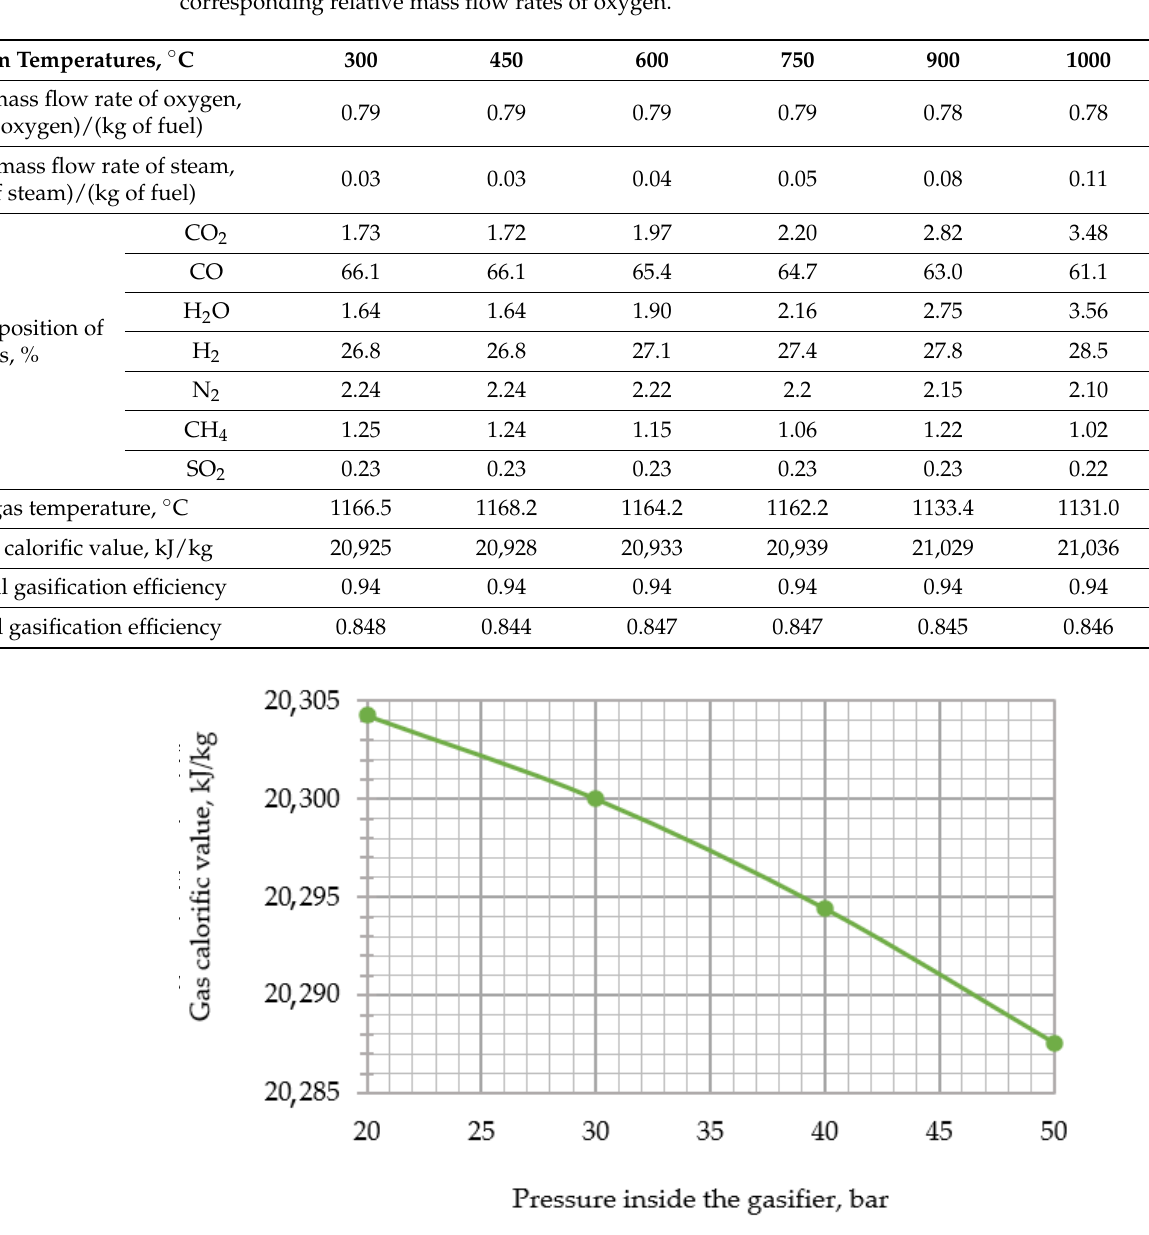
Figure 6. Dependence of syngas calorific value on gasification pressure.